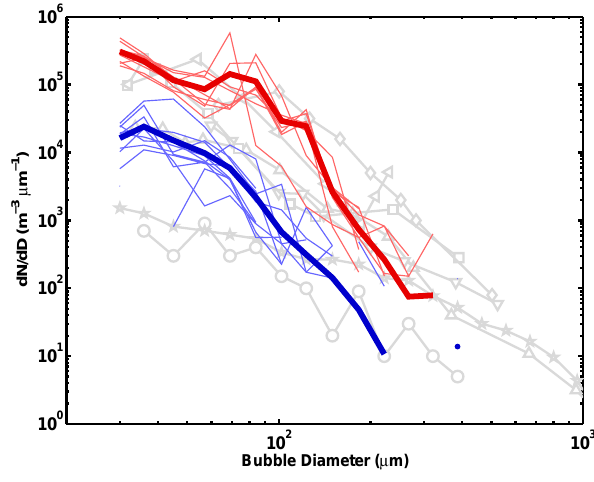
Fig. 7. Mean bubble spectra for each day (in colour). A number of open ocean (grey open symbols) and surf zone spectra (grey filled symbols) are shown for comparison. The SEASAW ( U = 8ms − 1 ), de Leeuw et al. (2003) (DL03, U = 5ms − 1 ), and the ASCOS data were all measured at a depth of approximately 0.4m using the same optical instrument. Acoustic measurement systems were utilized in the open ocean by DOGEE (averaged over a depth of 0–3m, U = 13ms − 1 ), Breitz and Medwin (1989) (BM89, depth 0.25m, U = 12 − 15ms − 1 ), Phelps and Leighton (1998) (PL98, depth 0.5m, U = 12 − 14ms − 1 ) and Johnson and Cooke (1979) (JC79, depth 0.7m, U = 11 − 13ms − 1 ), and in the surf zone by Leighton et al. (2004) (L04), Phelps et al. (1997) (P97), and Deane and Stokes (1999) (DS99). SEASAW and DOGEE measurements are summarized in Brooks et al. (2009).